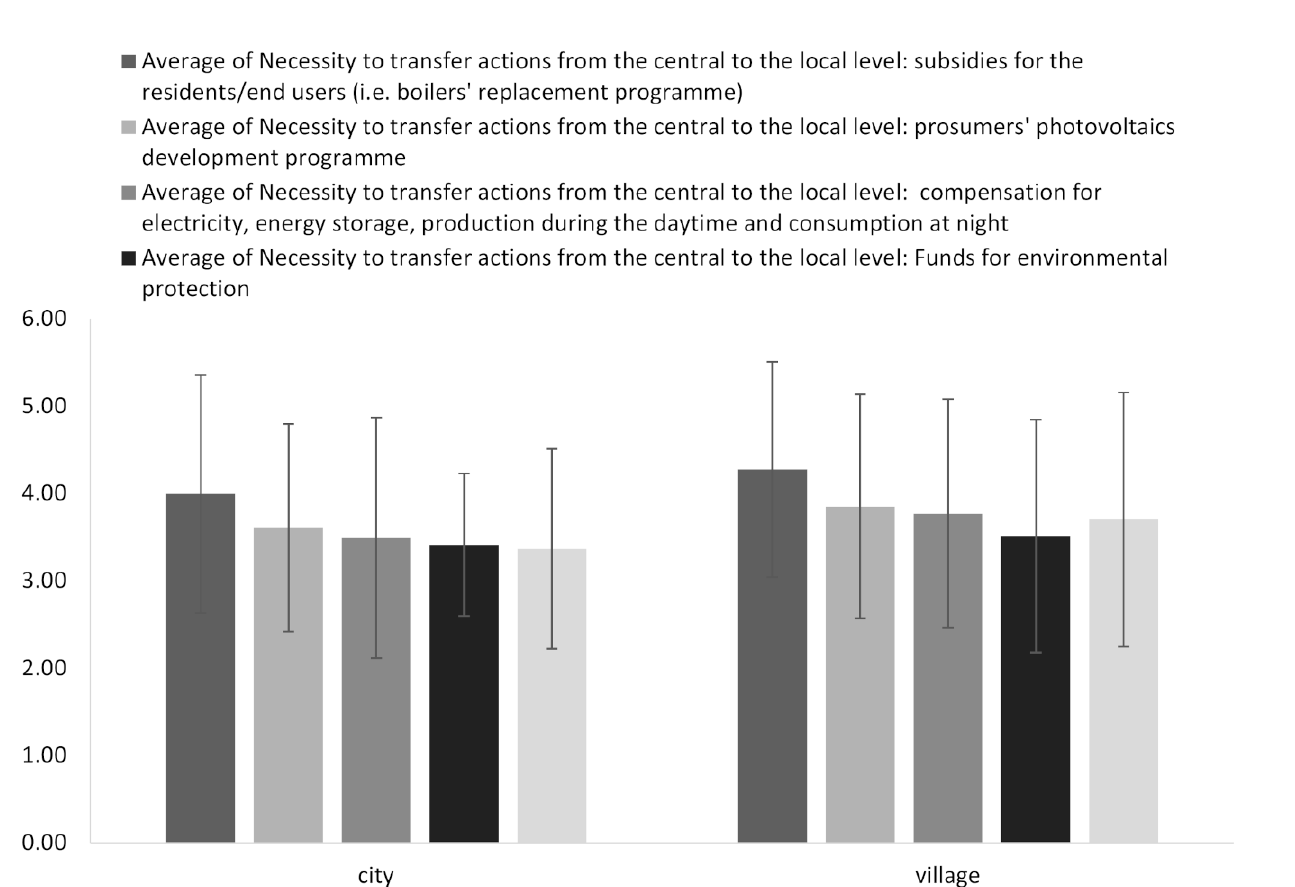
Figure 6. Average of necessity to transfer actions from the central to the local level. Source: Own research based on the results of an online survey, n = 444 (444 respondents who filled in the questionnaire online, of which 205 were men and 239 were women).